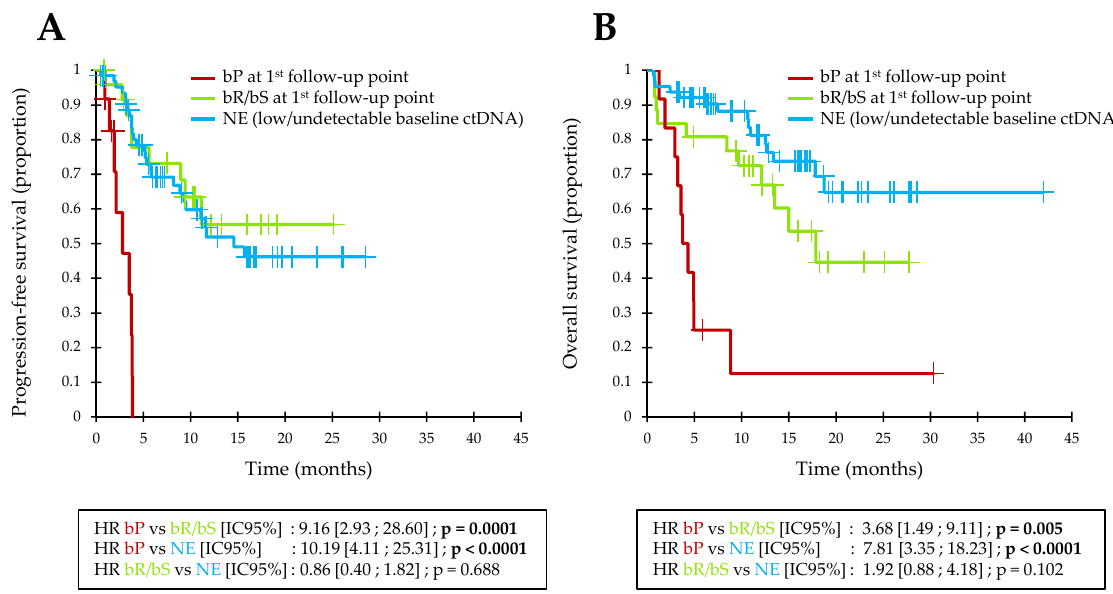
Figure 3. Kaplan–Meier estimates of PFS ( A ) and OS ( B ) in pooled analysis, depending on baseline ctDNA and biological response assessment at the first follow-up point.